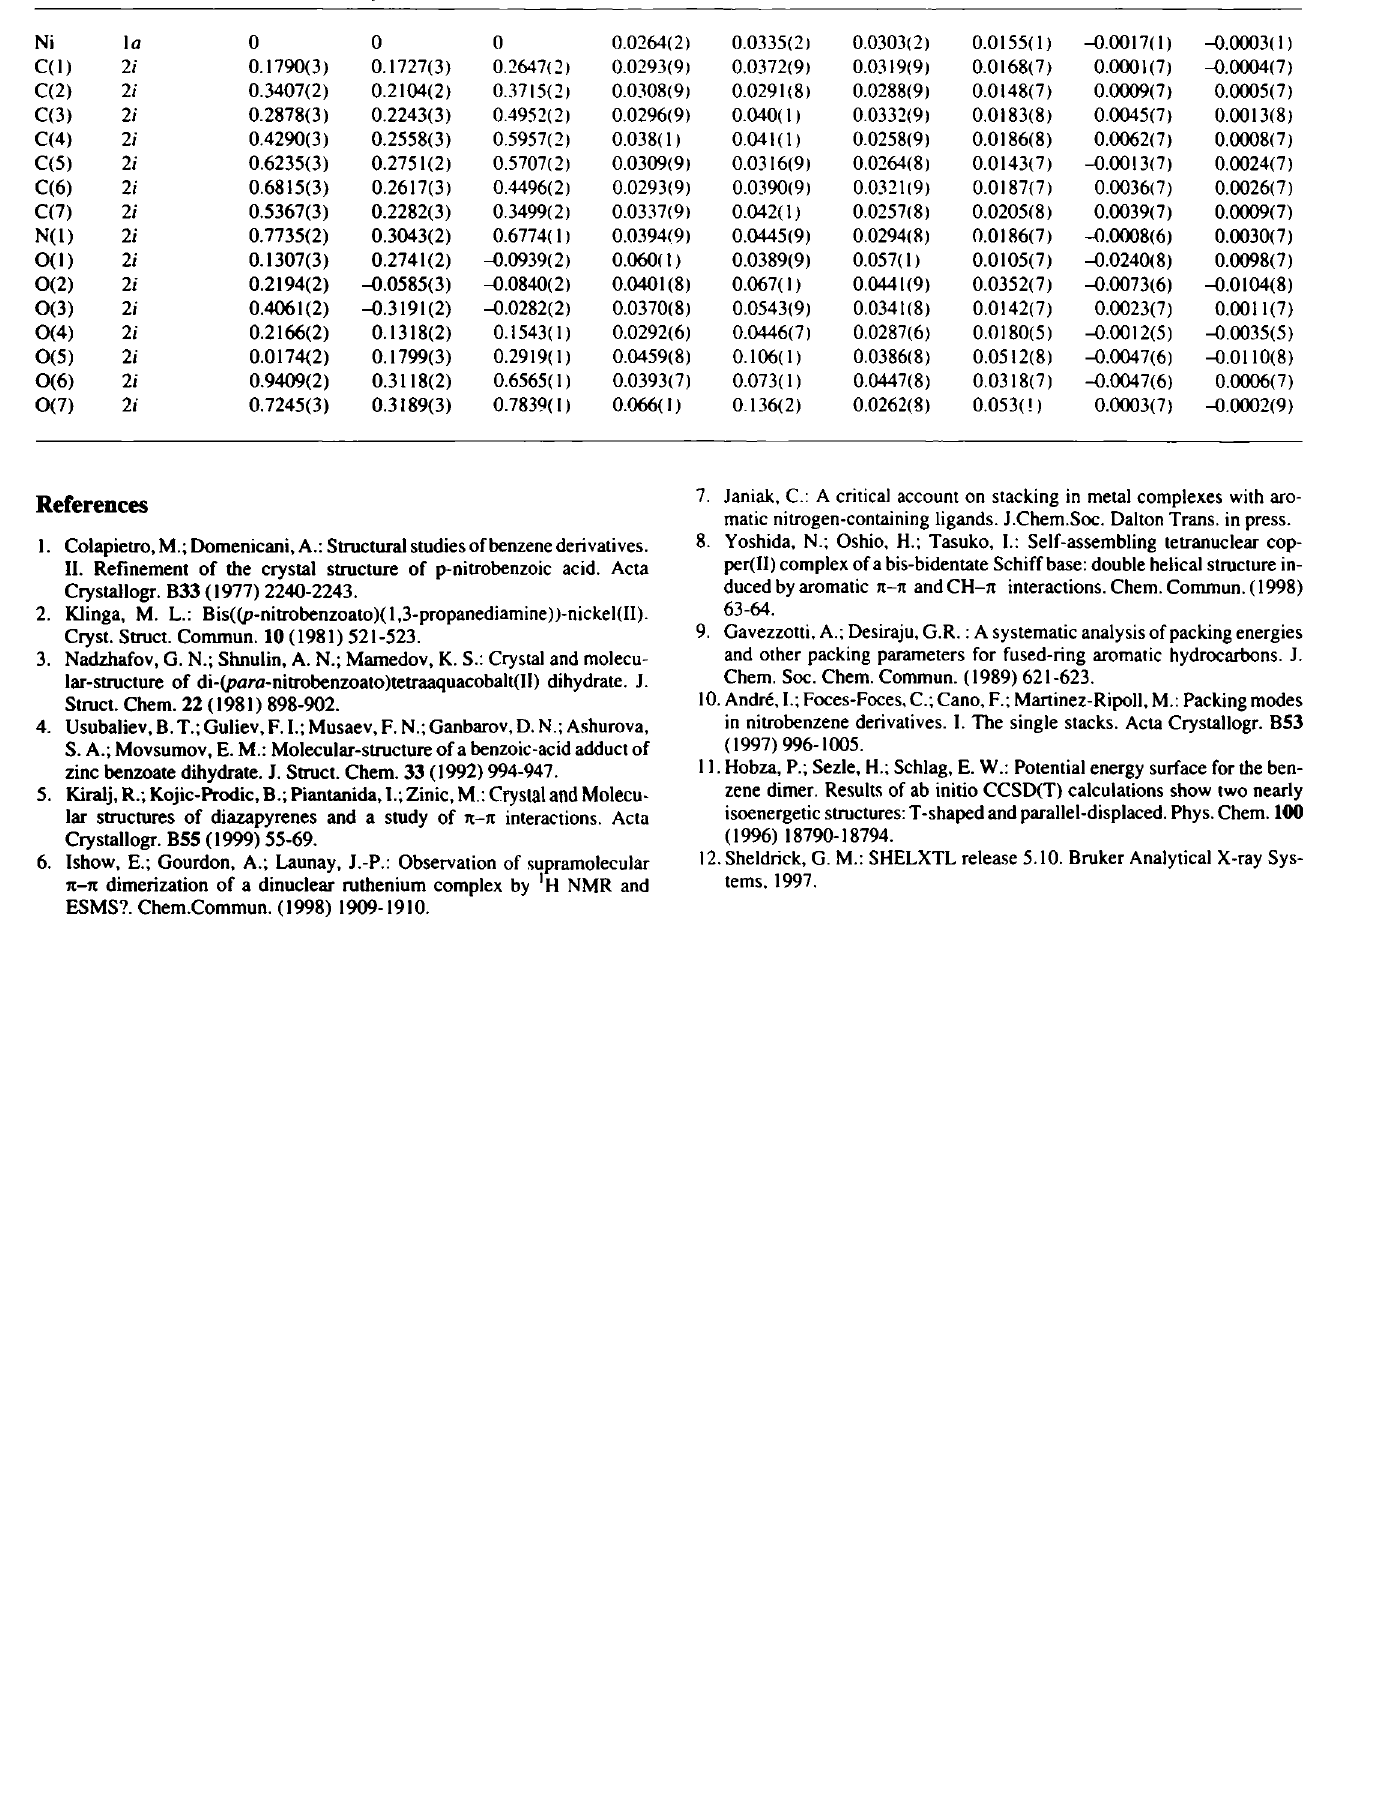
Table 6. Atomic coordinates and displacement parameters (in A :